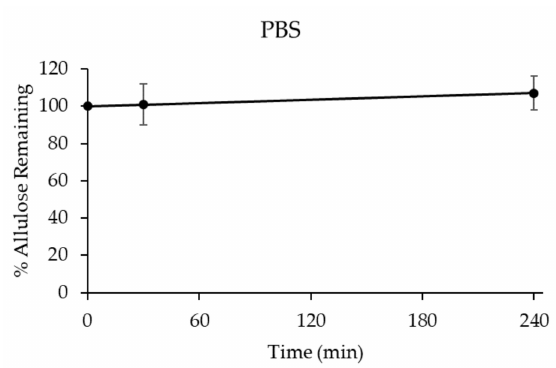
Figure 2. Percentages of D-allulose remaining as a function of time after incubation in PBS. Results are presented as means and error bars represent standard deviations. ( n = 5 at each time